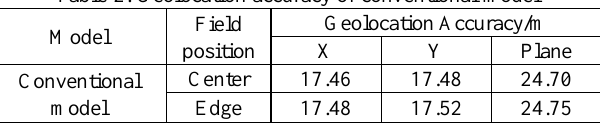
Fig 6 Error distribution of backward camera Table 2. Geolocation accuracy of conventional